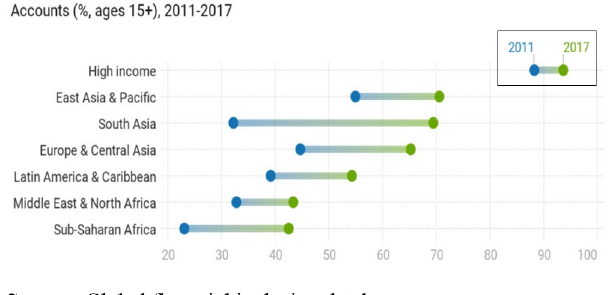
Figure 4. Accounts (%, ages 15 þ ),